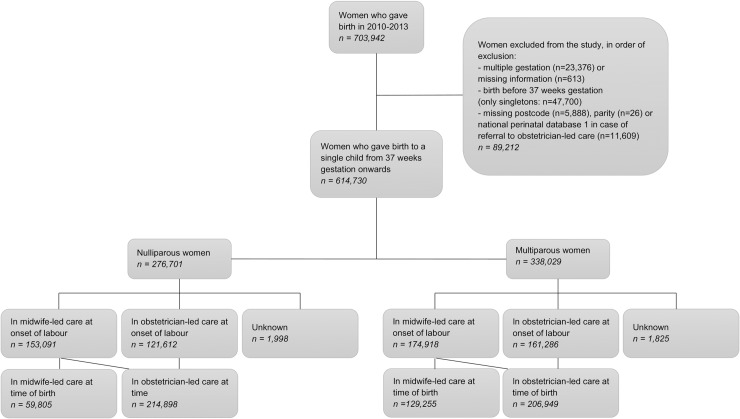
Study population.